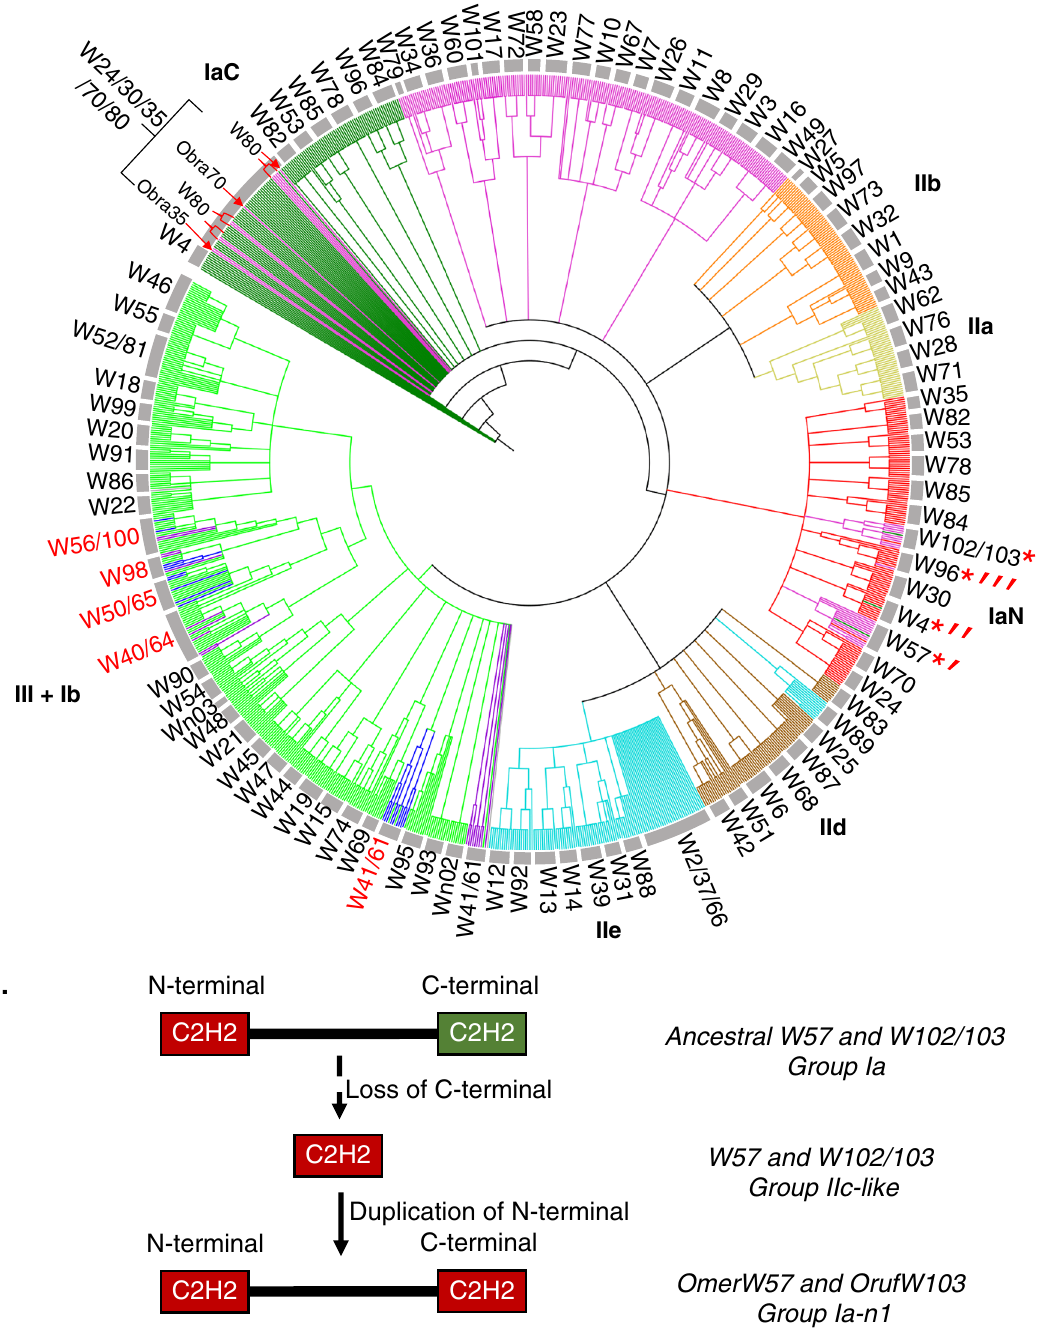
Figure 4. Phylogenetic construction of WRKY proteins from Oryza and hypothesized domain evolution. ( a ) Maximum likelihood tree of WRKY domain sequences using 1000 bootstrap replicates. Group IaN: red, Group IaC: dark green, Group IbN: blue, Group IbC: purple, Group IIa: yellow, Group IIb: orange, Group IIc: pink, Group IId: brown, Group IIe: cyan, Group III: light green, and Group IV: black. Clades have also been labeled according to orthologous group placement. Clades notated with two or more WRKY IDs indicate an intermixed clade. Red asterisks indicate novel group 1a WRKYs resulted from duplications of the N-terminal domain of more ancient group Ia proteins. Red arrows indicate novel WRKYs likely resulted from loss of the N-terminal WRKY domain of Group Ia proteins. Red font texts indicate clades with Group Ib. Nodes with bootstrap support < 50 are not shown. ( b ) Proposed hypothesis for how the clades observed in panel A for W57 and W102/103 could have occurred via the rapid loss and gain of WRKY domains. The hypothesis proposes that a Group Ia ancestor for each respective WRKY may have lost its C-terminus and left a IIc-like N-terminus, which subsequently duplicated within select lineages to create a novel Group Ia-like WRKYs (Group